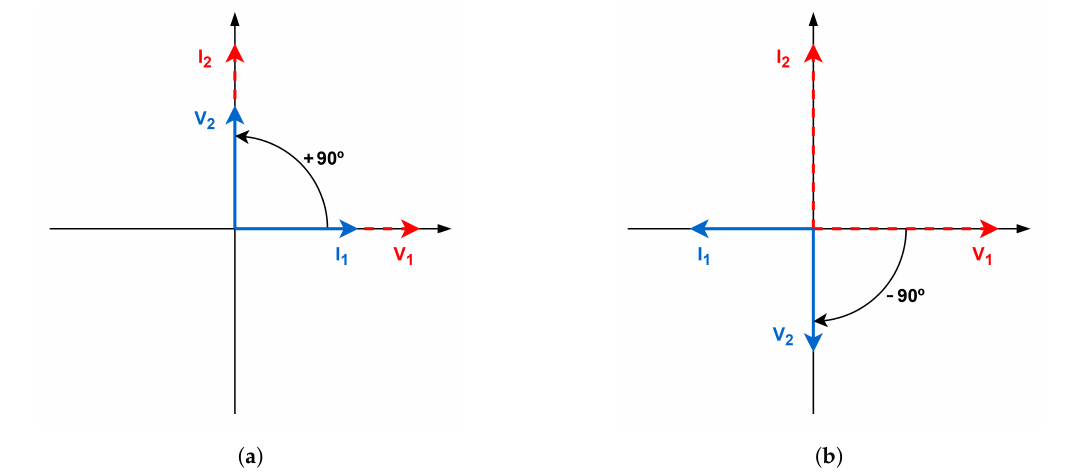
Figure 7. Phasor diagrams for both operation modes. ( a ) phasor diagram for the G2V mode; ( b ) phasor diagram for the V2G